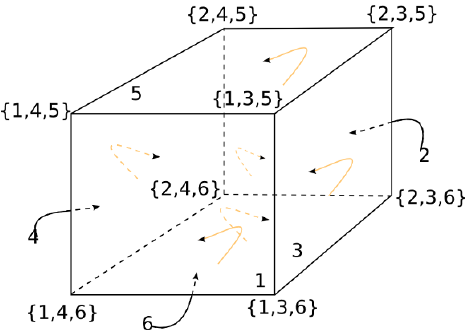
Figure 12 . A three-dimensional cube with the green arrows depicting the cyclic list associated with its respective